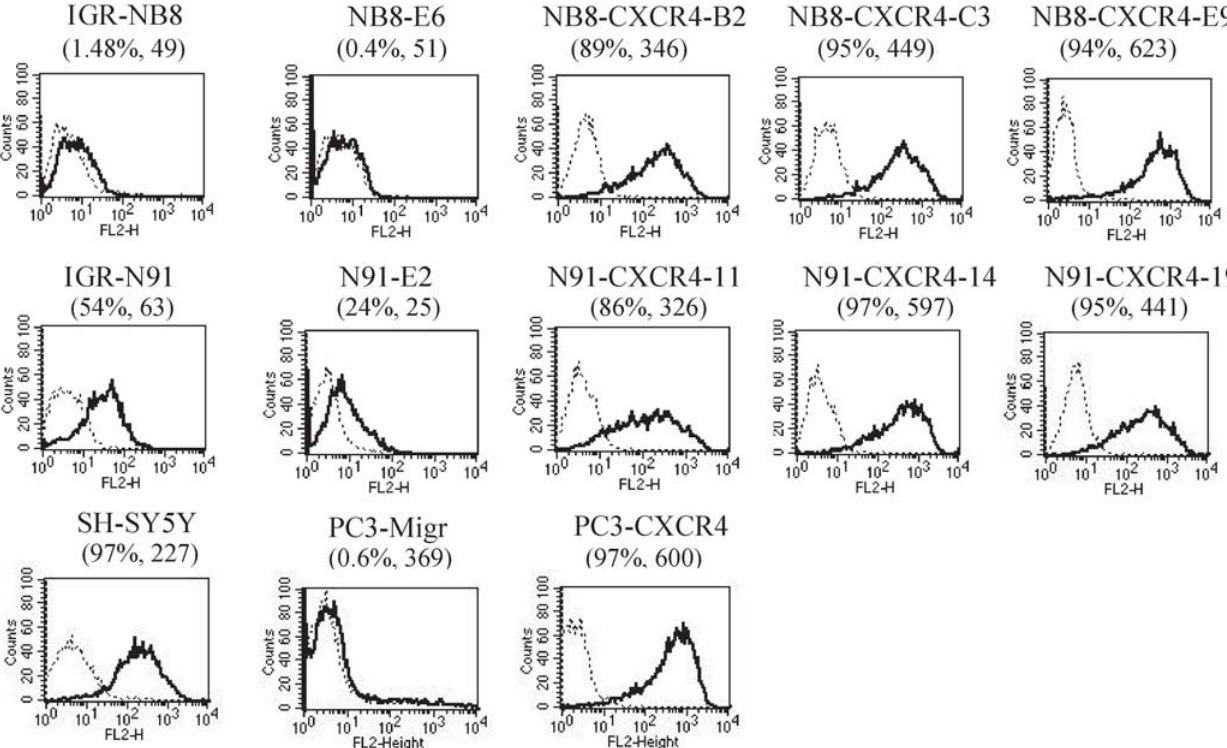
Figure 1. CXCR4 cell surface expression. IGR-NB8 and IGR-N91, two well characterized NB cell lines, and transduced cell lines/clones were analyzed for their cell surface CXCR4 expression by flow cytometry (FACS). Percent positive cells is indicated as well as the mean fluorescent intensity (brackets) of the CXCR4 staining. The NB cell line SH-SY5Y constitutively expressed high levels of CXCR4 as previously described [21]. The prostate cancer cell line PC3 showed comparable levels of CXCR4 expression upon transduction as NB8-CXCR4 and N91-CXCR4